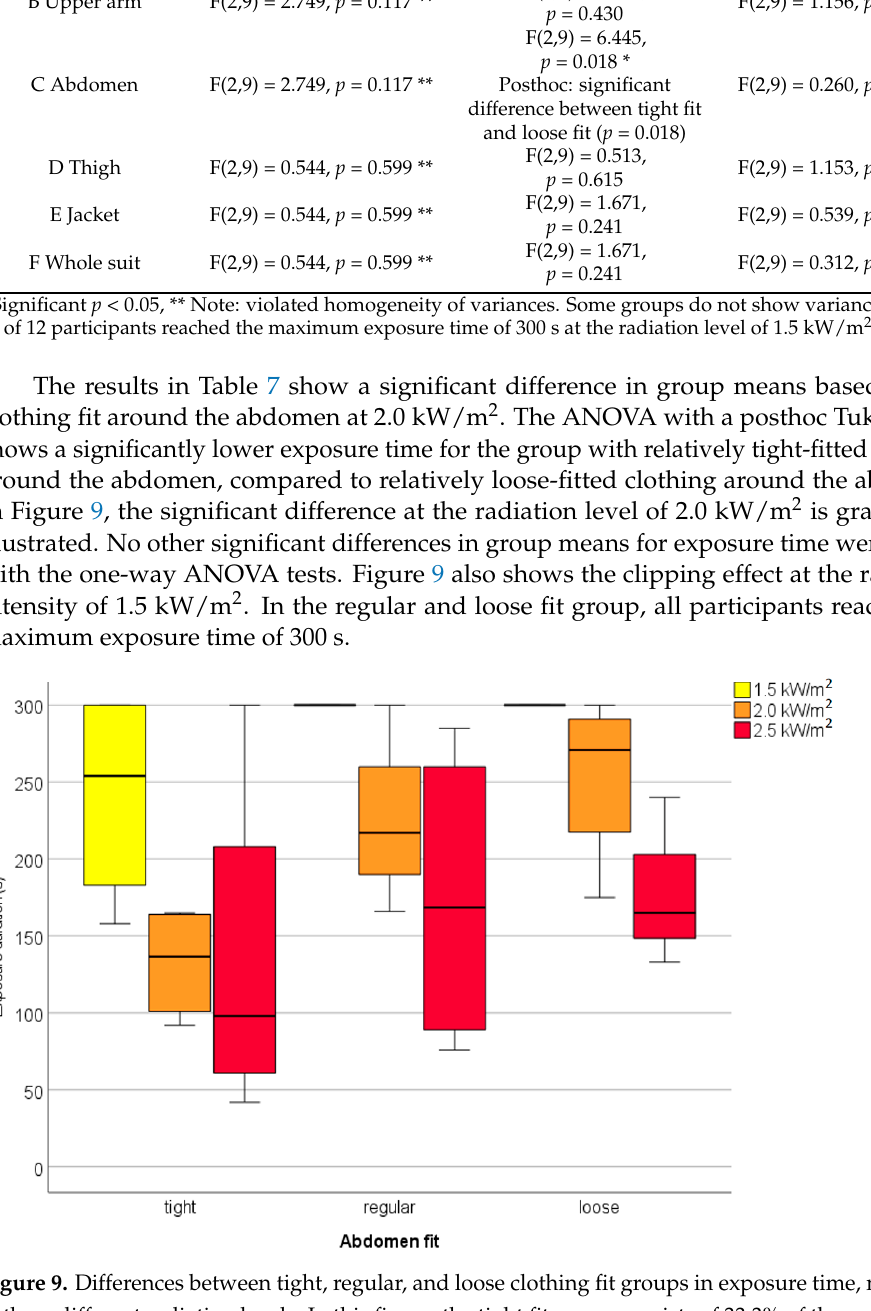
Table 7. Differences between tight, regular, and loose clothing fit group means in exposure time. Groups Based on